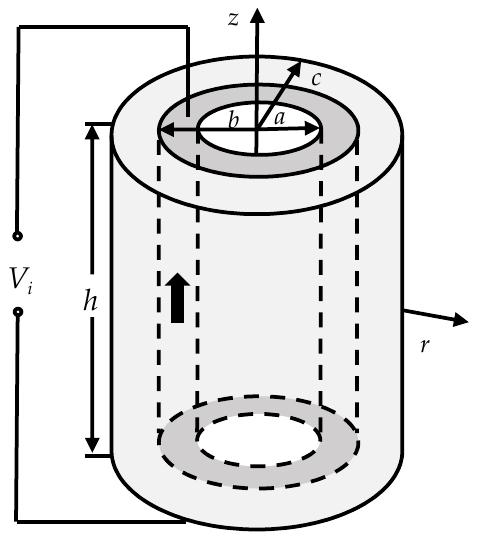
Figure 1. Radial composite tubular transducer.